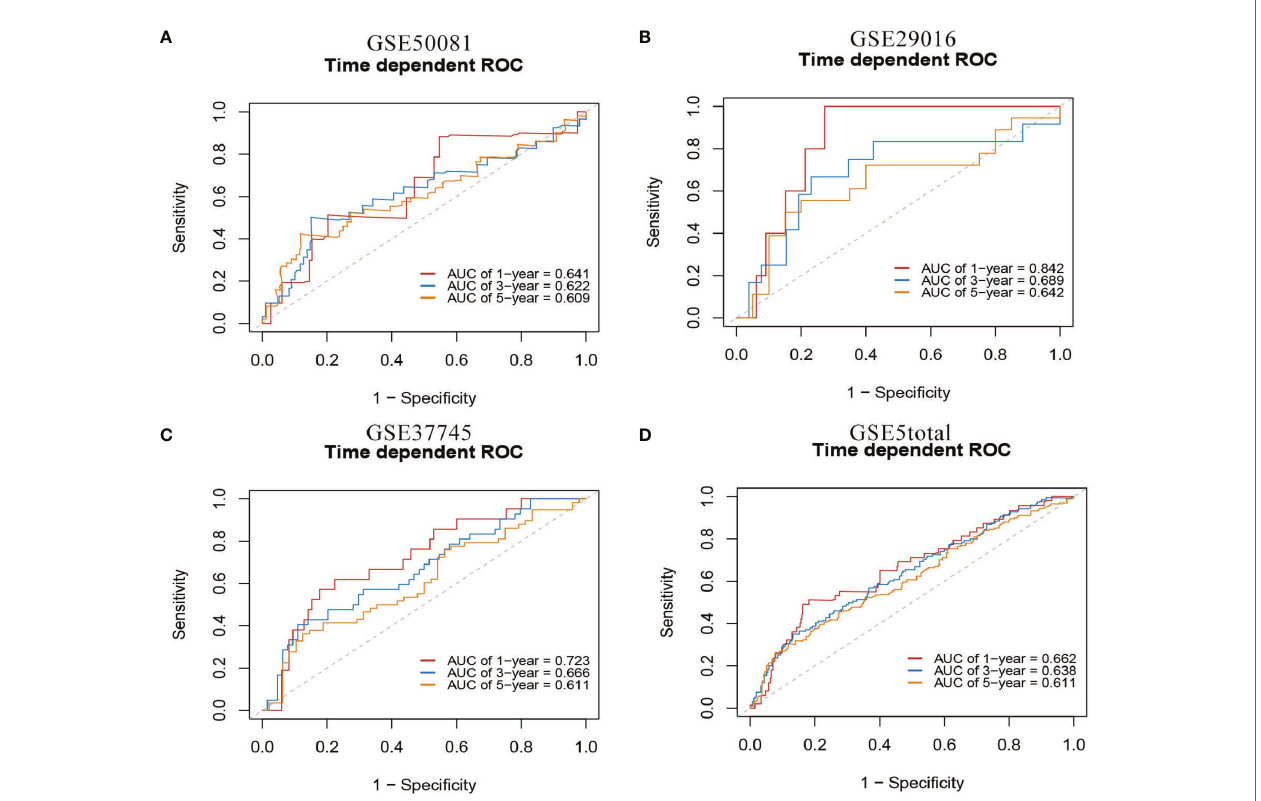
FIGURE 5 | 1-,3-,5-year ROC curves of mRNA model in external validation data sets. (A) GSE50081 dataset. (B) GSE29016 dataset. (C) GSE37745 dataset. (D) GSE5total